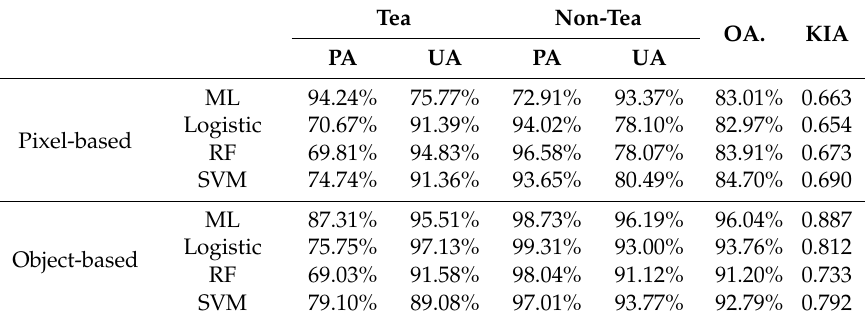
Table 7. Comparison of the accuracy assessment of pixel- and object-based approaches.